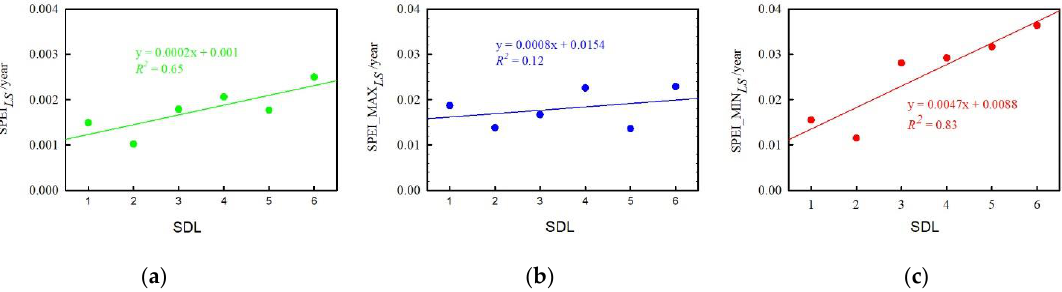
Figure 7. Relationship between SDLs and average SPEI LS , SPEI_MAX LS , and SPEI_MIN LS . ( a ) SPEI LS vs. SDL. ( b ) SPEI_MAX LS vs. SDL. ( c ) SPEI _MIN LS vs. SDL.